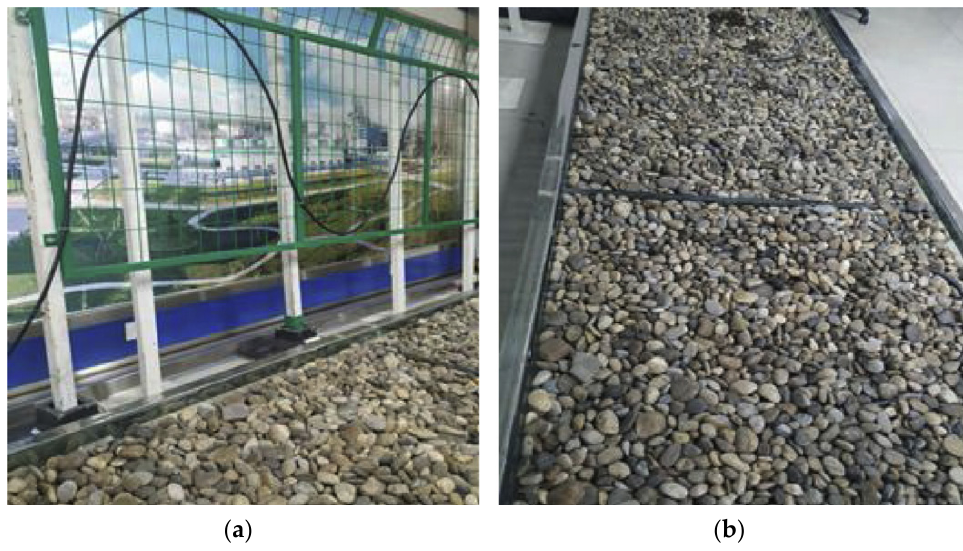
Figure 3. Laboratory testing environment; ( a ) hanging net; ( b ) and buried.